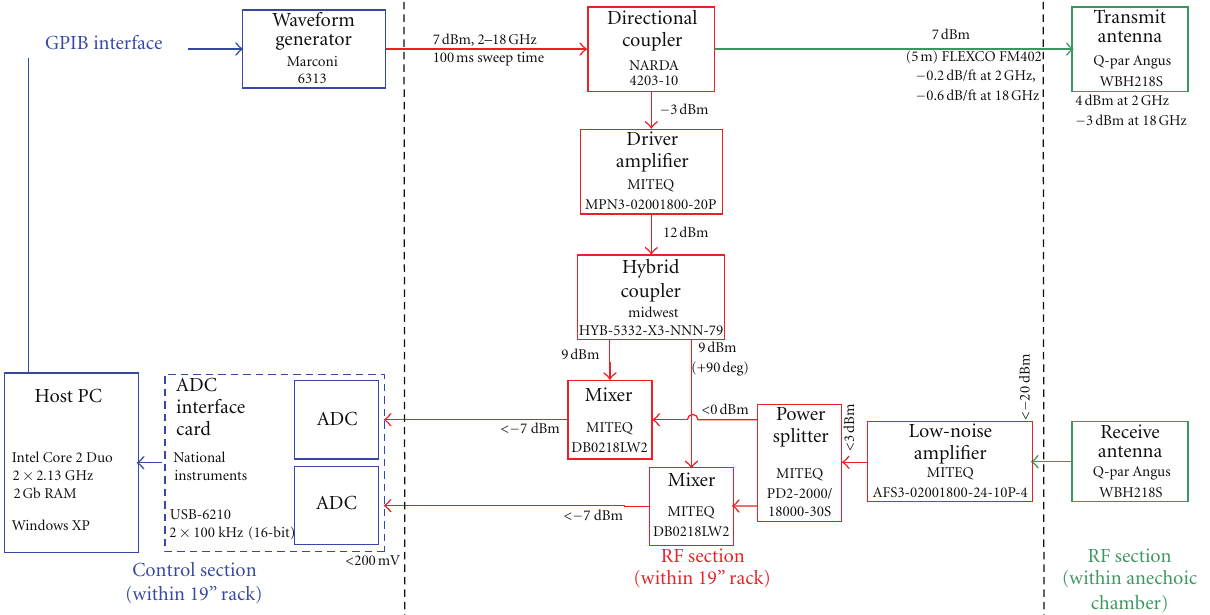
Figure 4: Schematic of radar hardware showing power levels detected at various